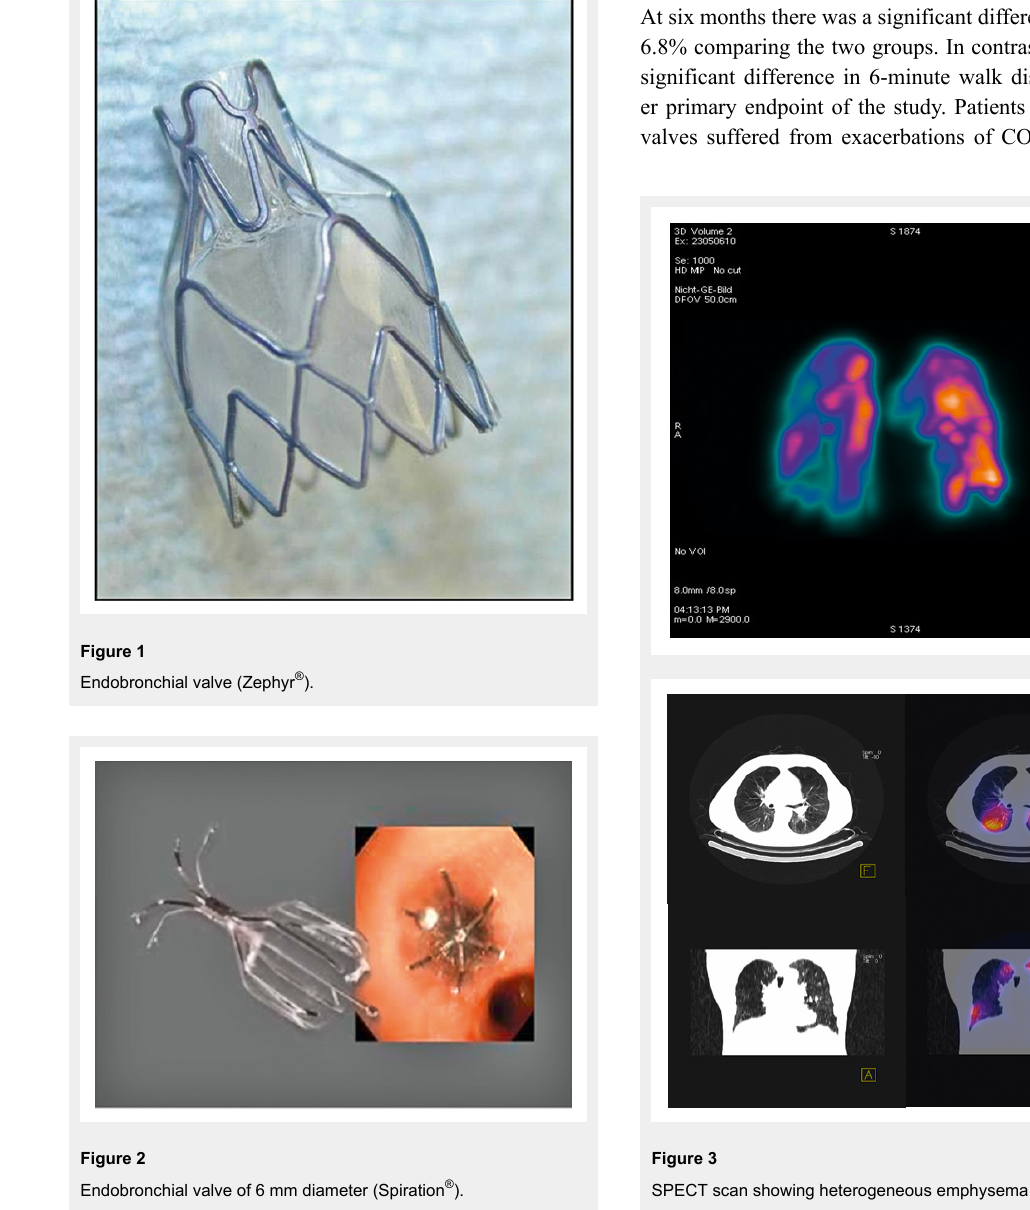
Endobronchial valve of 6 mm diameter (Spiration ®